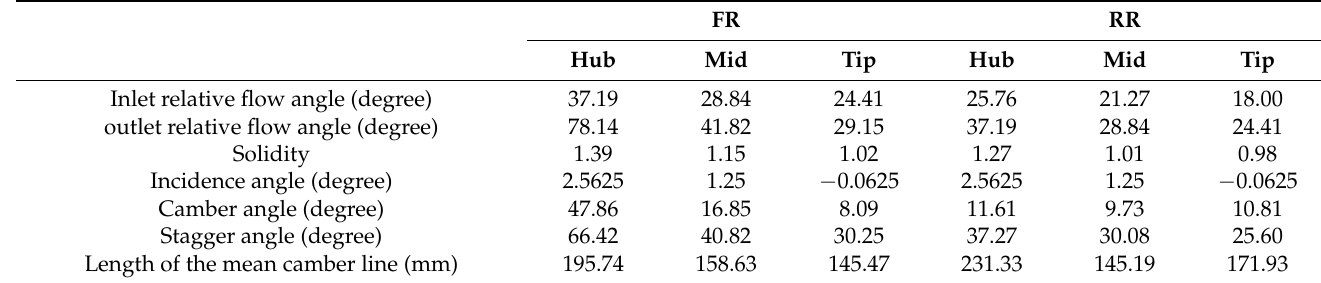
Table 8. Profile data of blades of CRF (R).